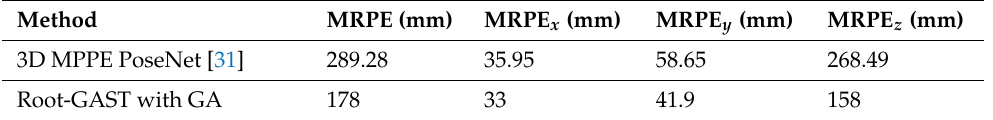
Table 5. MRPE results comparison with RootNet [31] on the Human3.6M dataset. MRPE x , MRPE y , and MRPE z are the average MRPE errors in the x, y, and z axes, respectively.